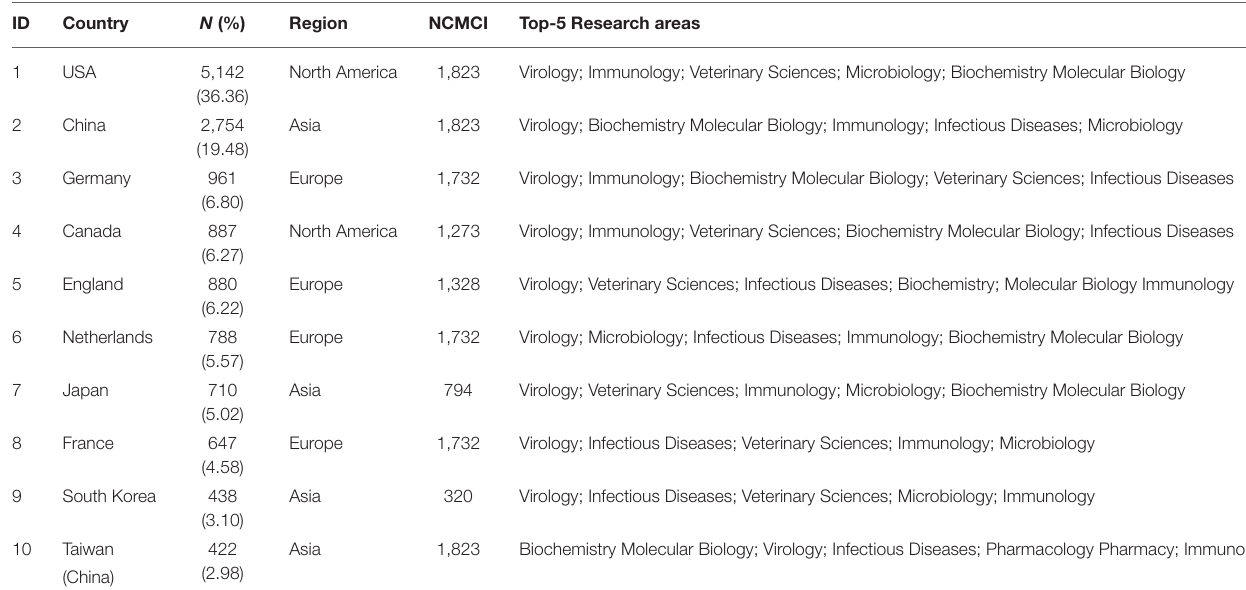
TABLE 1 | Characteristics of top-10 countries ( N =